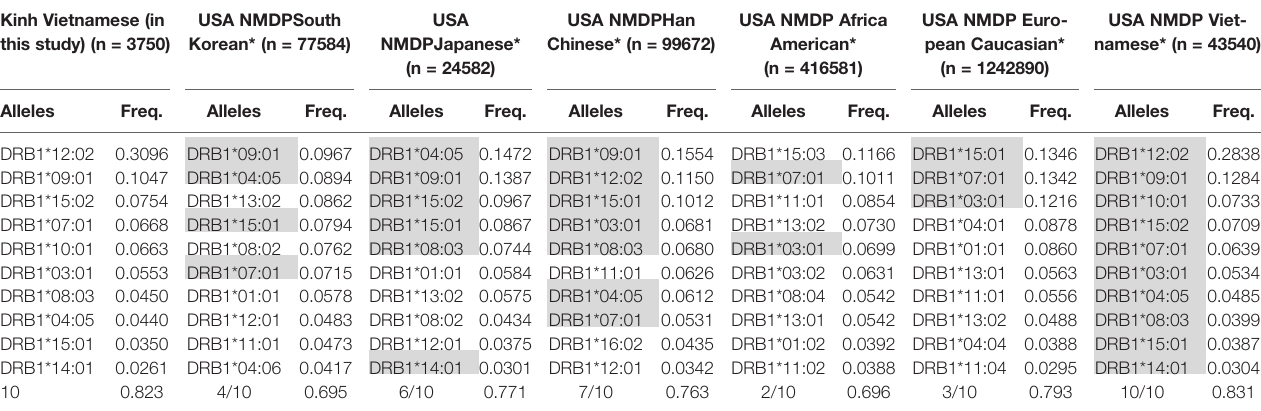
*From the allele frequency net, the grey background indicates common alleles shared between the Kinh Vietnamese and other